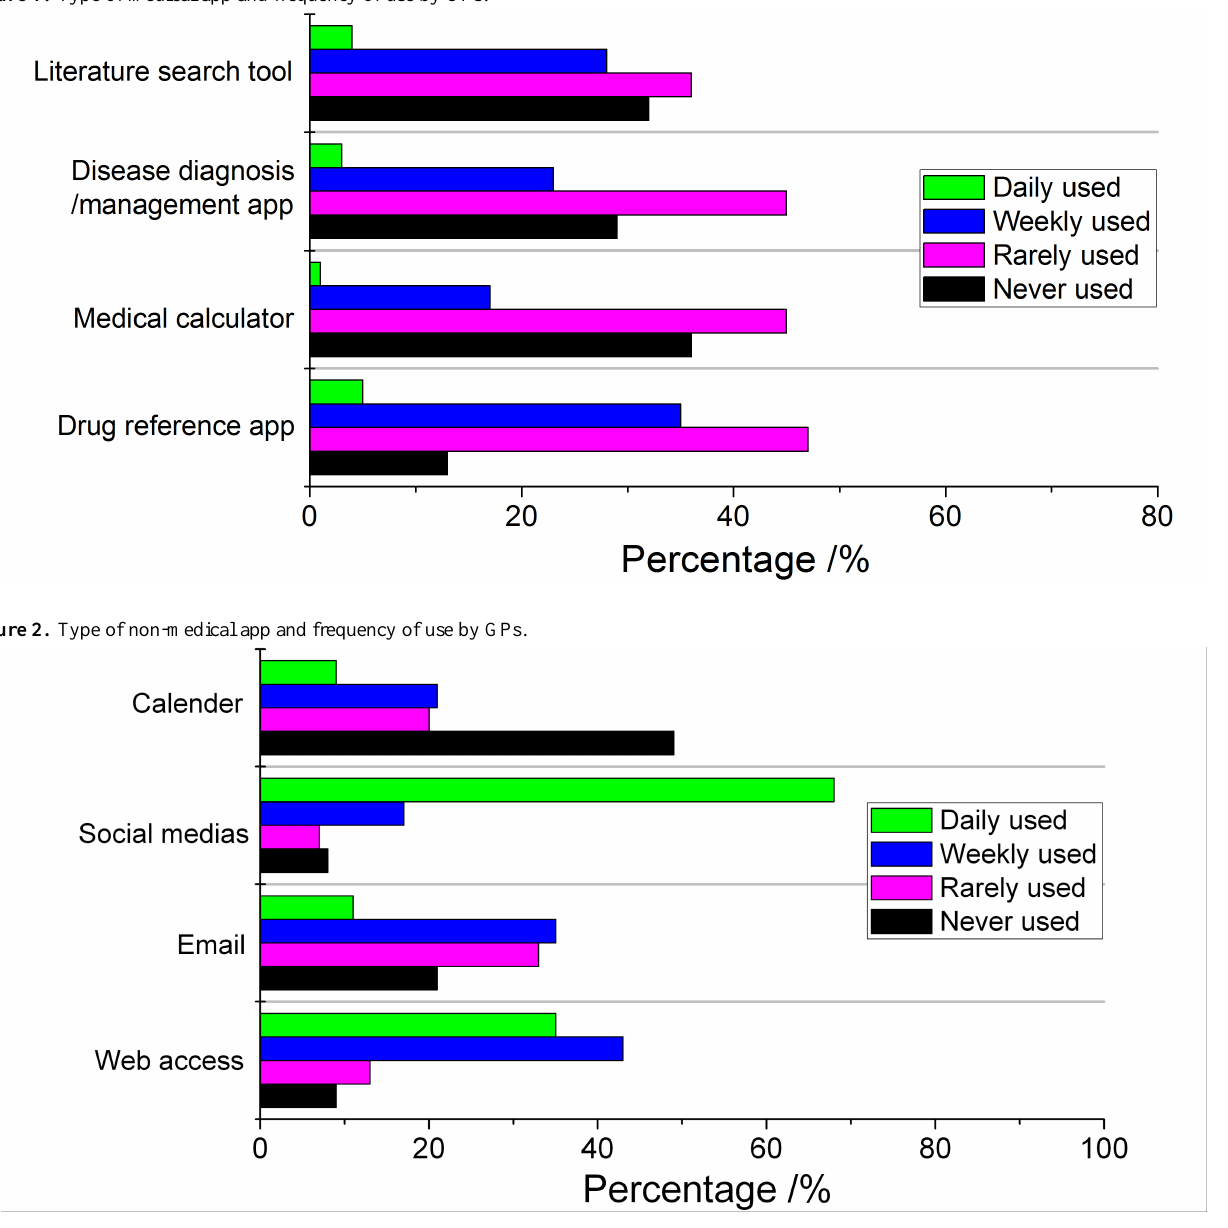
Figure 1. Type of medical app and frequency of use by GPs.